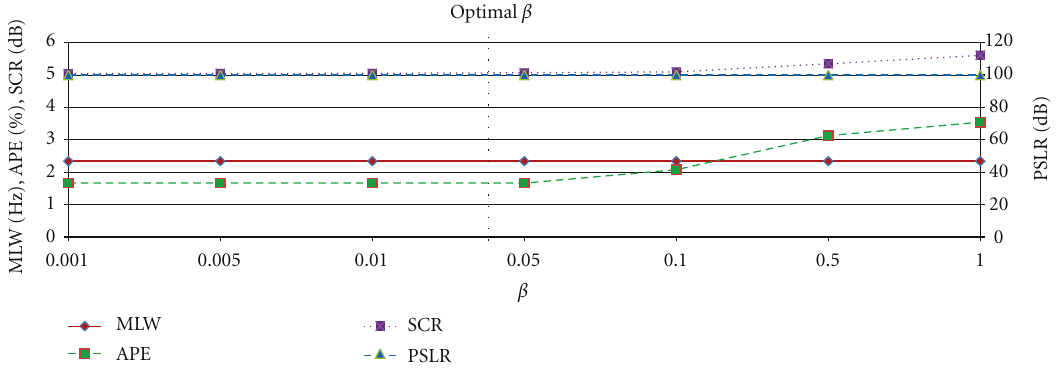
Figure 7: Performance comparison of the TFR using MBD with various β for swell signal.